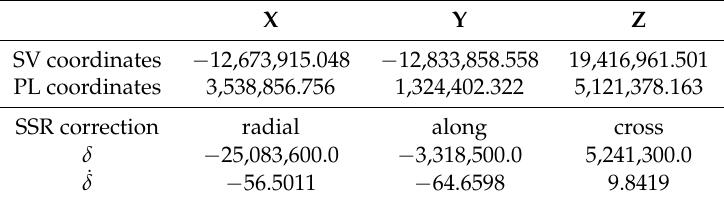
Table 6. SV and PL coordinates/Vector of pseudolite SSR